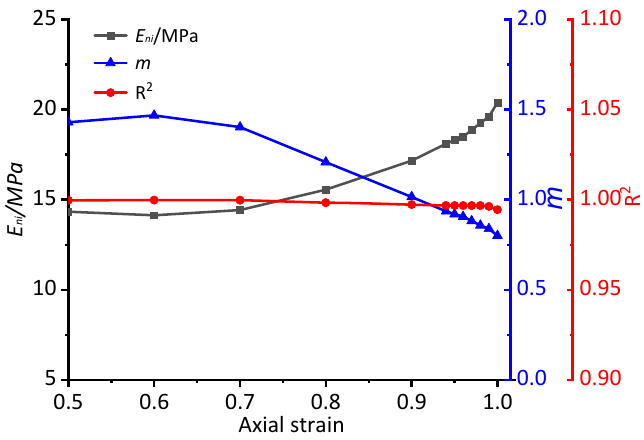
Figure 6. Fitting results of different strain ranges. The different curves of the unified nonlinear elastic model with the E ni values and m values, which were both obtained after fitting different curve ranges, are listed in Figure 7. The red line was calculated using the parameters after fitting the curve from 0 to 1.0, and is the curve of best fit.